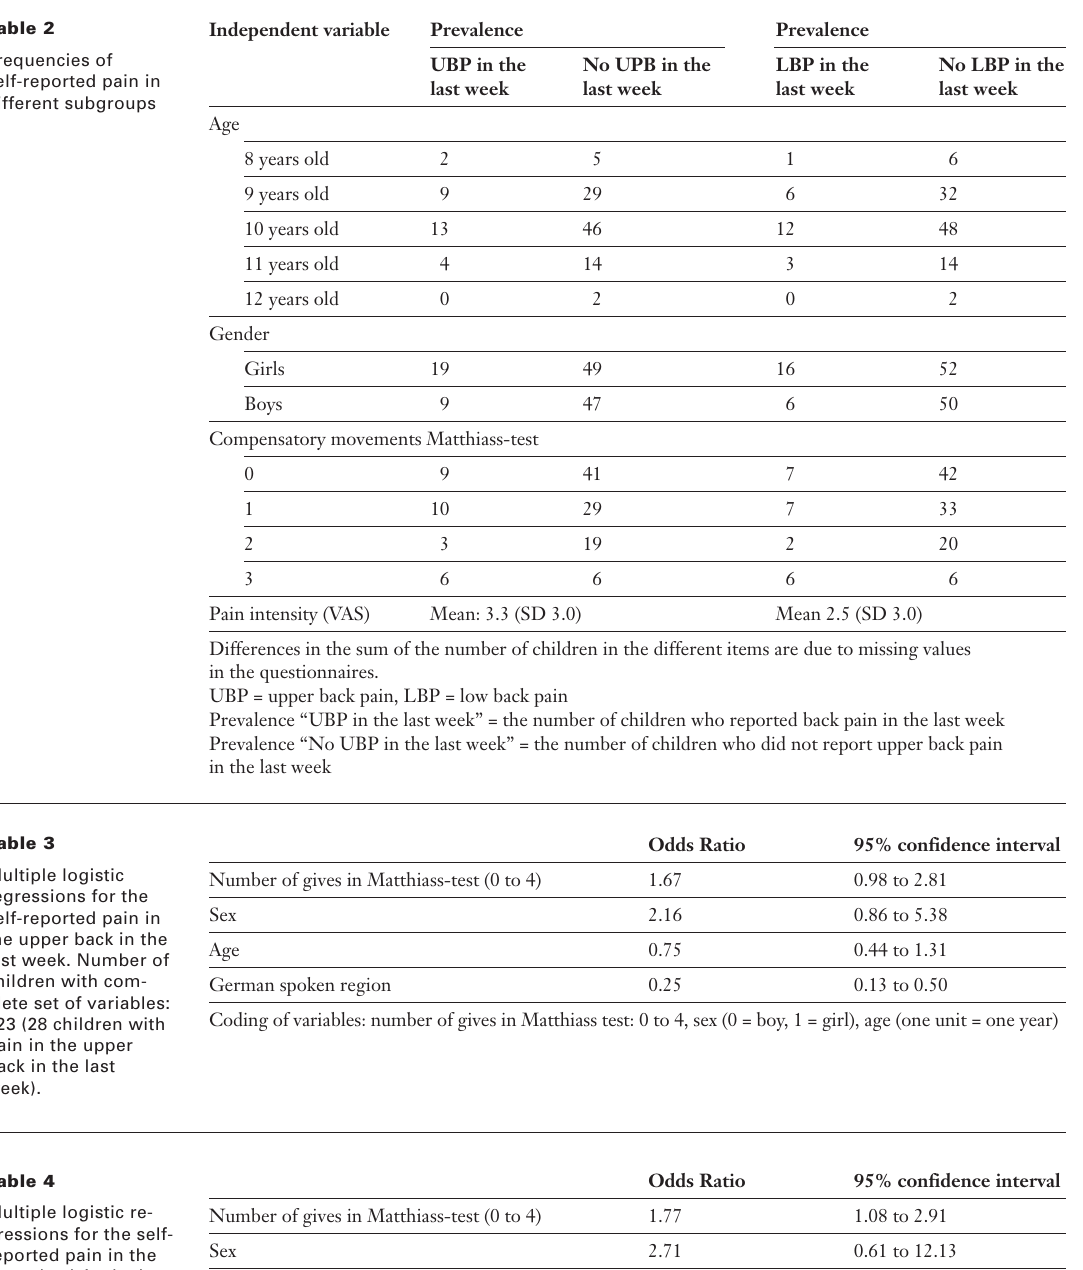
Multiple logistic re- gressions for the self- reported pain in the lower back in the last week. Number of children with com- plete set of variables: 123 (22 children with back pain in the lower back in the last